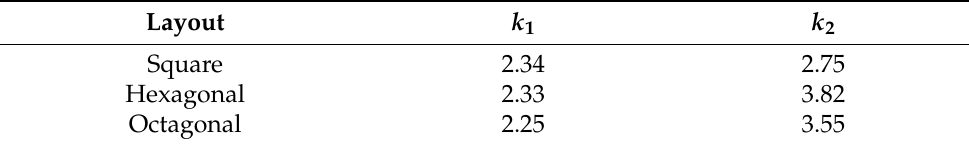
Table 3. Coefficients for Modified Wheeler